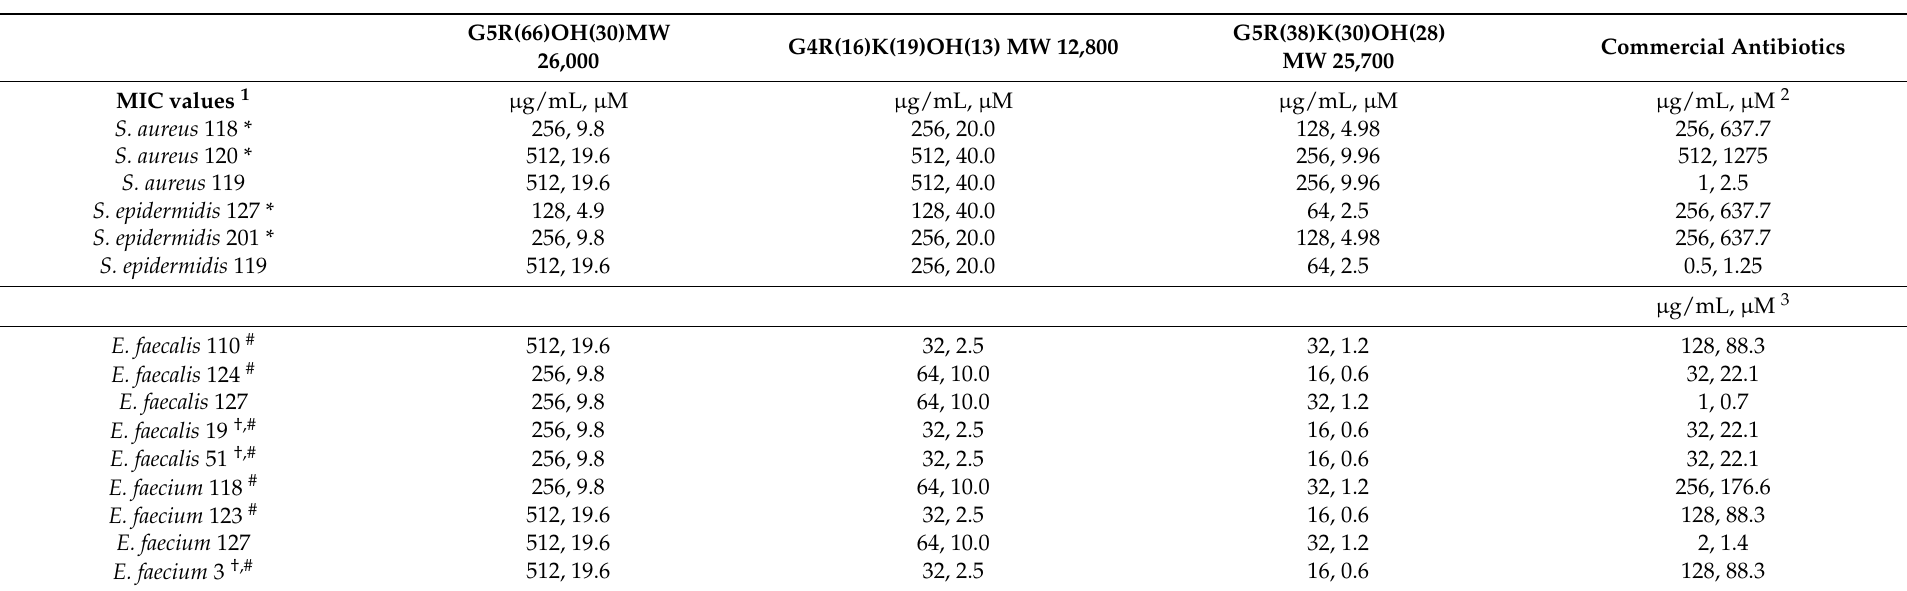
Table 4. MIC values of the three cationic empty dendrimers, expressed as µ g/mL and millimolarity (mM), against the Gram-positive strains tested in the